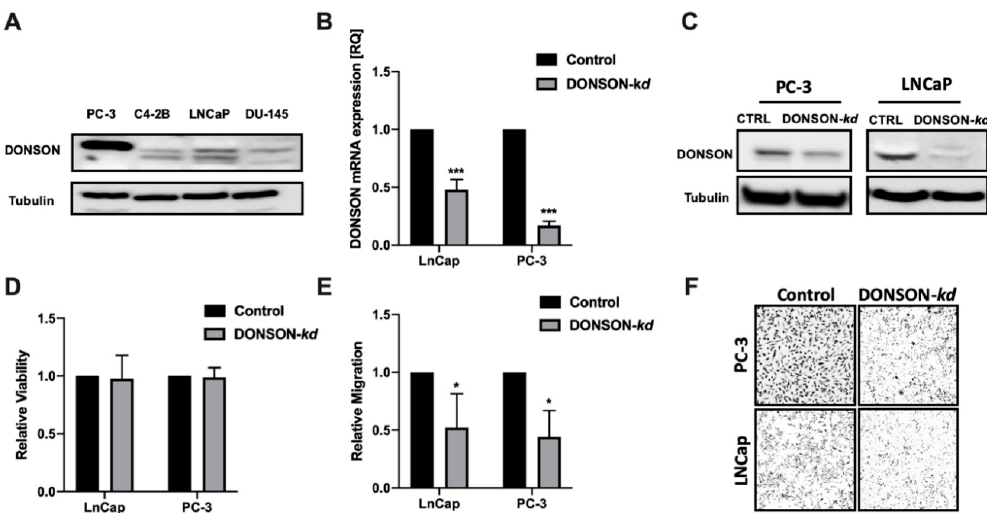
Figure 4. Effect of specific DONSON-depletion in the PCa cell lines LNCaP and PC-3. ( A ), Screening Western Blot for DONSON in four broadly used PCa cell lines. ( B , C ), Induction of efficient Antisense LNA GapmeR-mediated DONSON knockdowns in LNCaP and PC-3 with subsequent validation via qPCR ( B ) and Western Blotting ( C ). ( D , E ) DONSON-depletion did not affect cell viability but specifically reduced the cellular motility in a Boyden Chamber Migration Assay. ( F ), Membranes depicted in 10× objective magnification. Each experiment was performed in biological triplicates. * p < 0.05, *** p < 0.001.